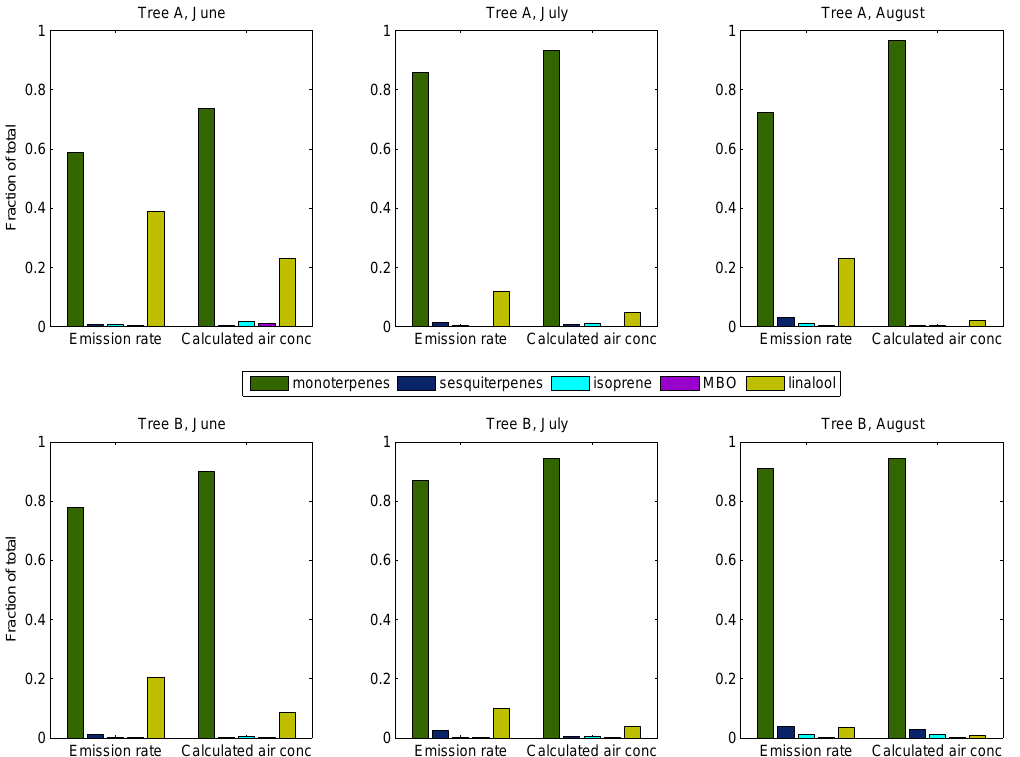
Fig. 6. Relative emission rates of the measured VOCs and their calculated air concentrations due to oxidation with OH and ozone.